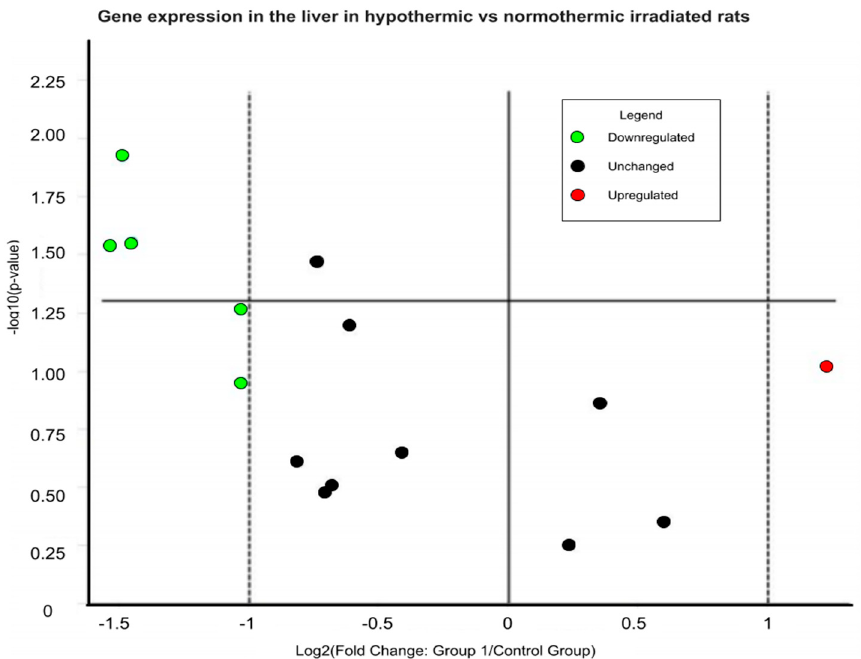
Figure 2. Volcano plot representing the expression of the analysed genes in the liver (normothermic vs hypothermic animals) 4 h after a total body irradiation (X-rays, 3Gy) expressed as normalized fold change. In green: genes downregulated (to the left of the left dashed line). In red: genes upregulated (to the right of the right dashed line). Dots above the solid horizontal line are significantly different between the two groups.